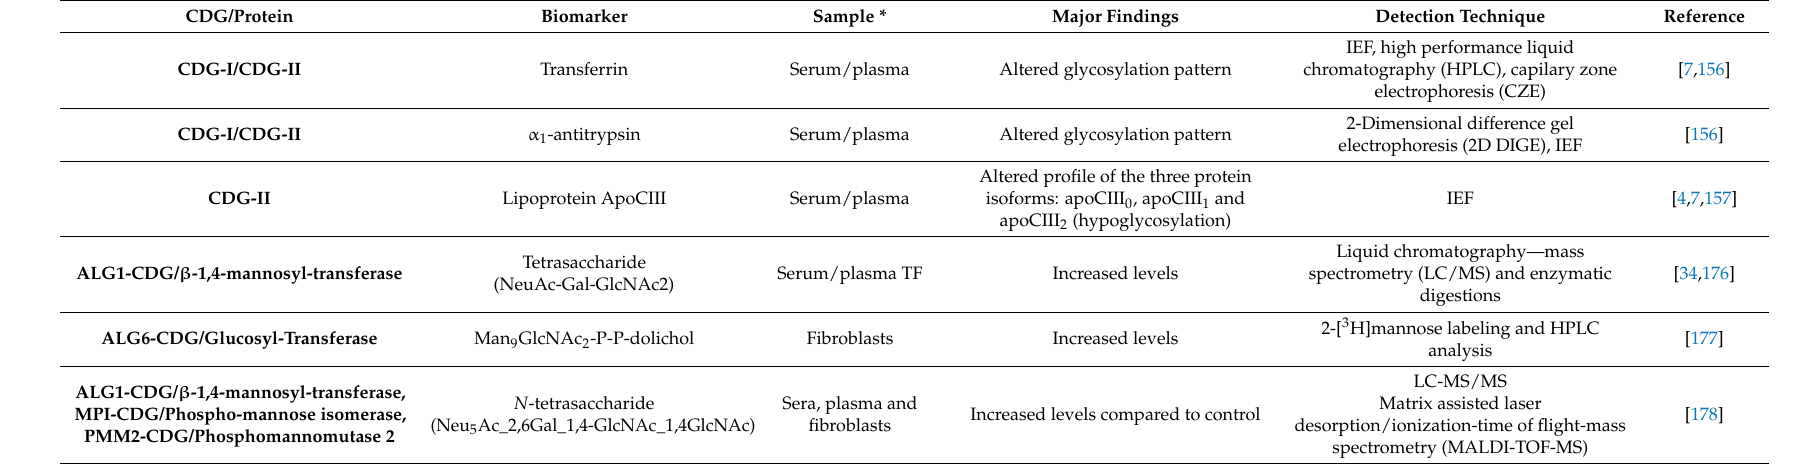
Table 2. Overview of diagnosis biomarkers reported for CDG.